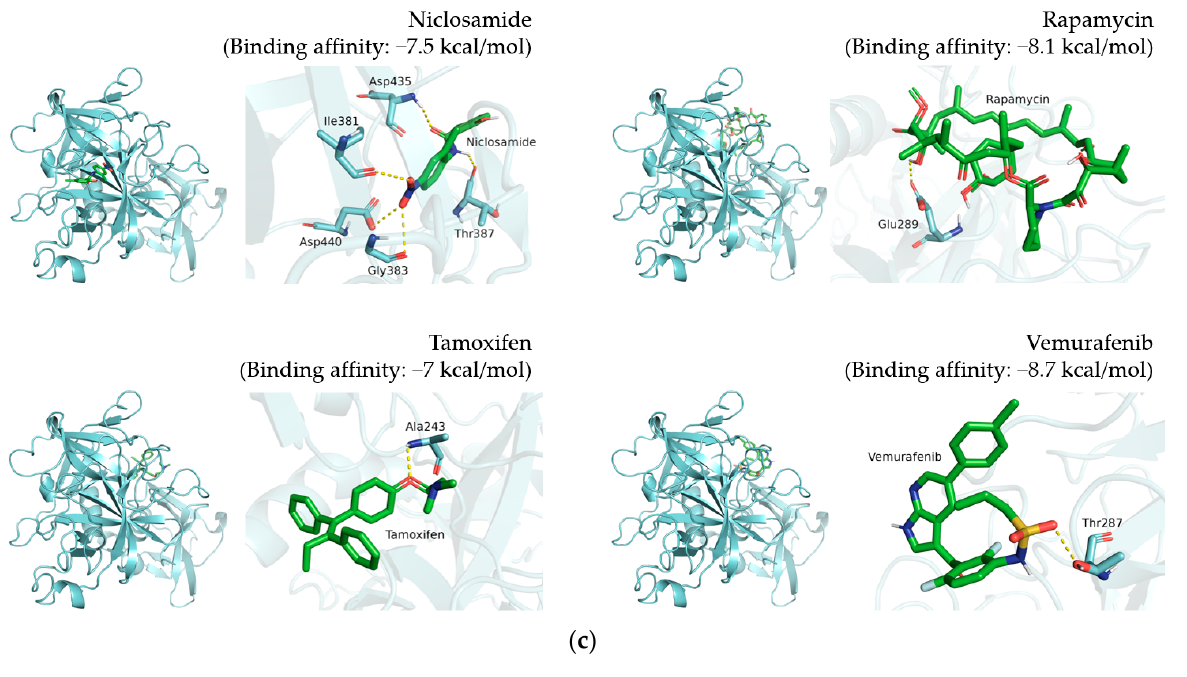
Figure 2. Docking results of 12 candidate compounds for TMPRSS2. ( a ) Afatinib, atorvastatin, dactinomycin and doxorubicin. ( b ) Ethacrynic acid, neratinib, mepacrine and homoharringtonine. ( c ) Niclosmide, rapamycin, tamoxifen and vemurafenib. These results present the pose 1 binding pattern of each compound in the whole protein and polar contact residue view. TMPRSS2 and compounds are shown in cyan and green, respectively. The polar contacts are marked with yellow dashes.